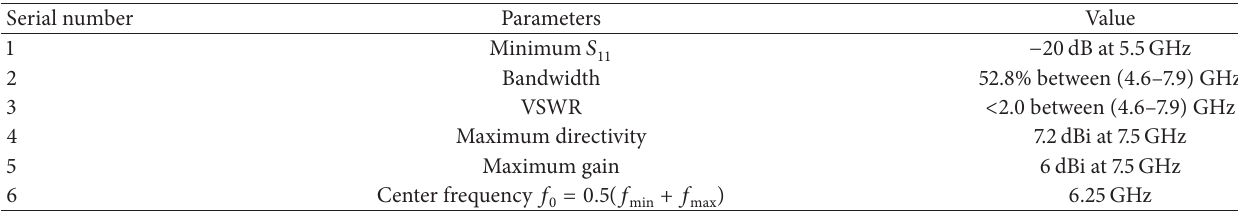
Table 5: Basic electrical characteristics of the proposed antenna.